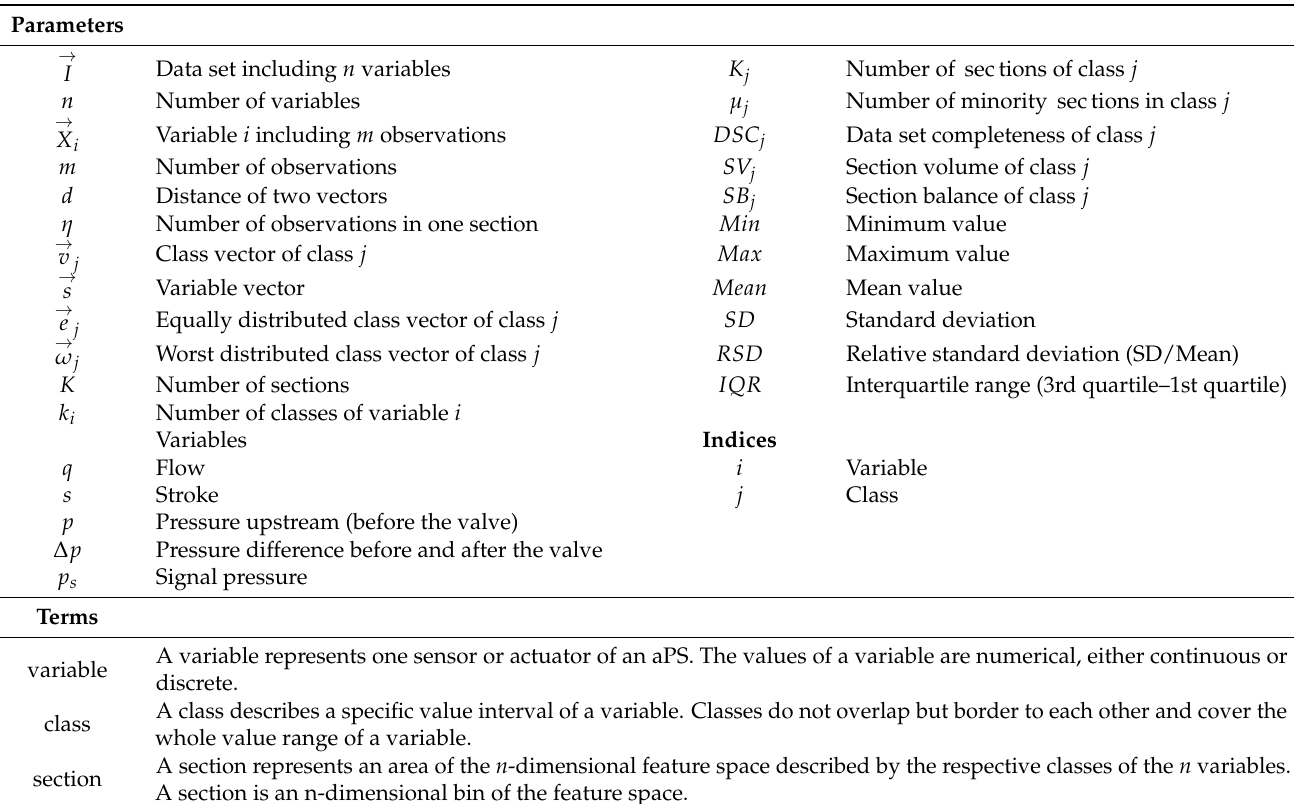
Table 2. Nomenclature for the concept of data set